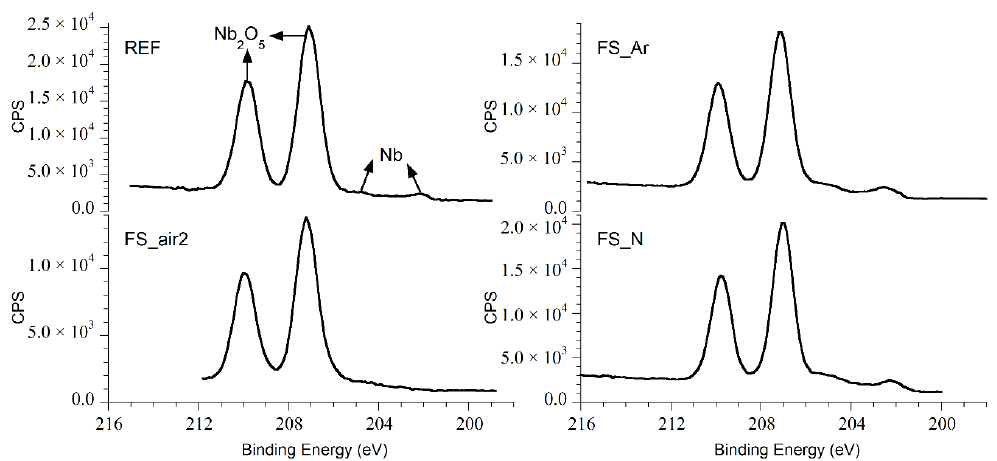
Figure 4. High resolution Nb 3d XPS spectra for the analyzed samples discussed in the text. CPS: counts per second.